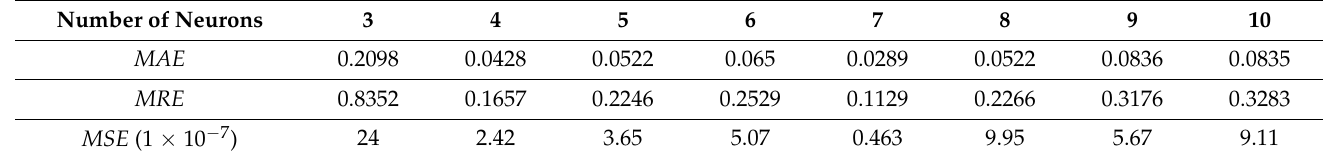
Table 10. Influence of number of hidden-layer neurons on neural network using Tansig transfer function.